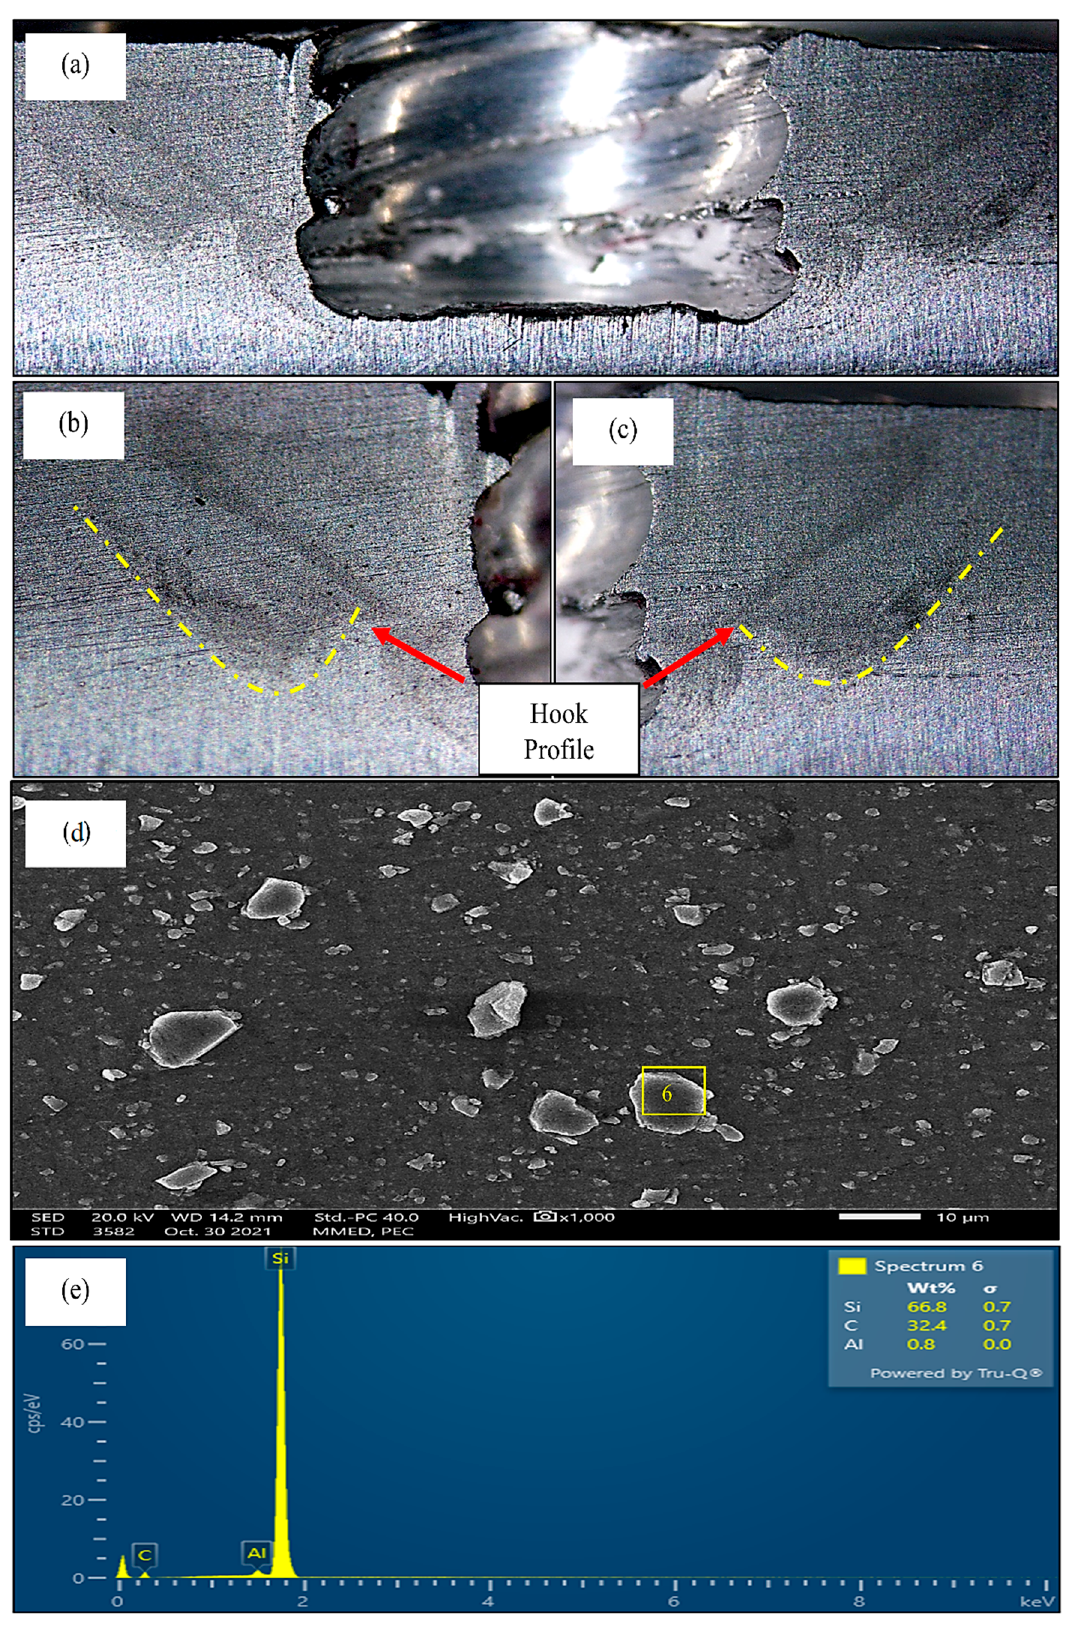
Figure 12. ( a ) Macrograph of the weld with SiC; ( b ) left side of the weld from the centre, with hook profile; ( c ) right side of the weld from the centre, with hook profile; ( d ) SEM image of the sample obtained with SiC; ( e ) EDS analysis.